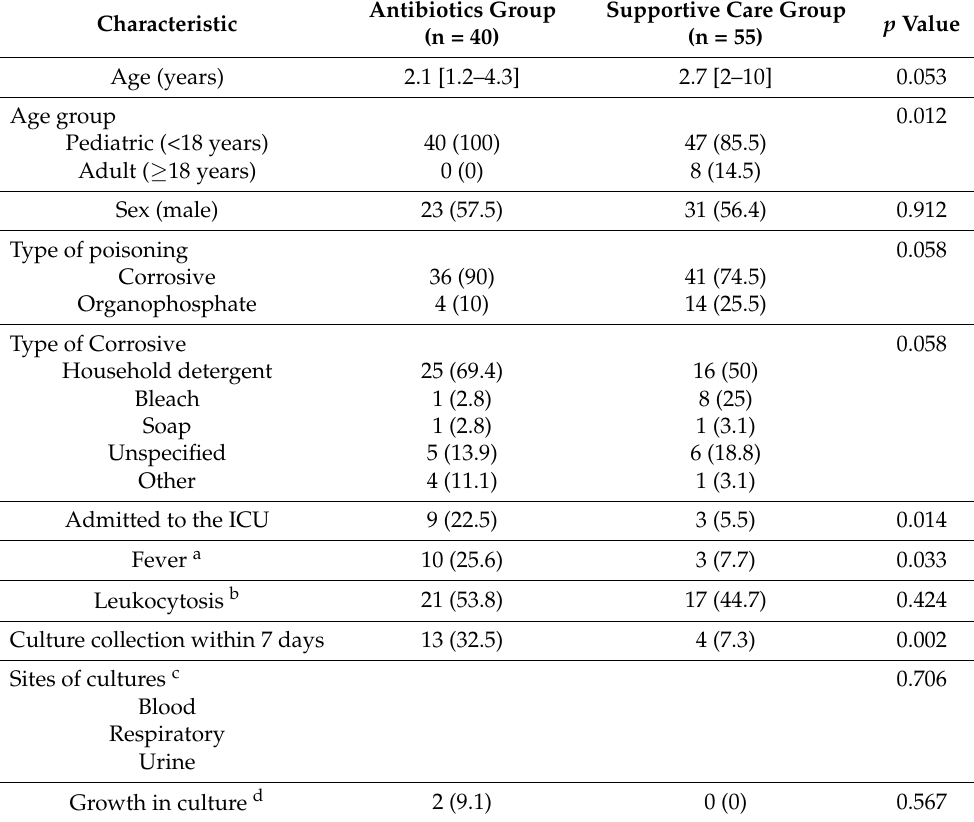
Table 1. Baseline characteristics of